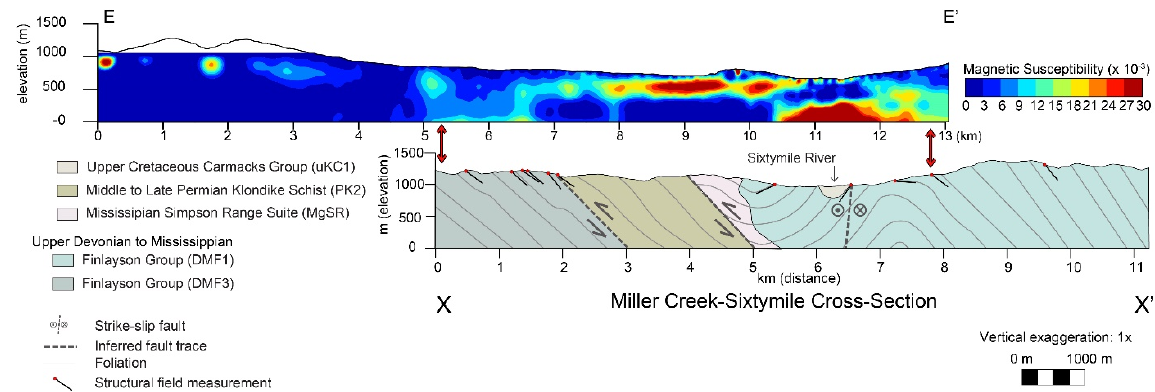
Figure 17. Comparison between the magnetic susceptibility cross-section E-E ′ and the Miller Creek- Sixtymile River cross-section.